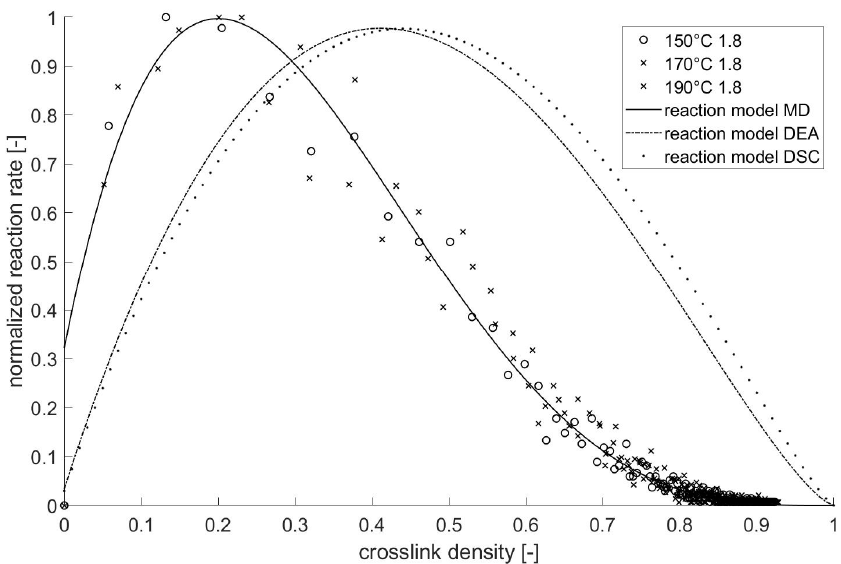
Figure 8. Comparison of the kinetic model derived using MD , DEA , and DSC methods. Table 5. Parameters in the reaction model estimated by regression with a confidence interval of 95 %. Method